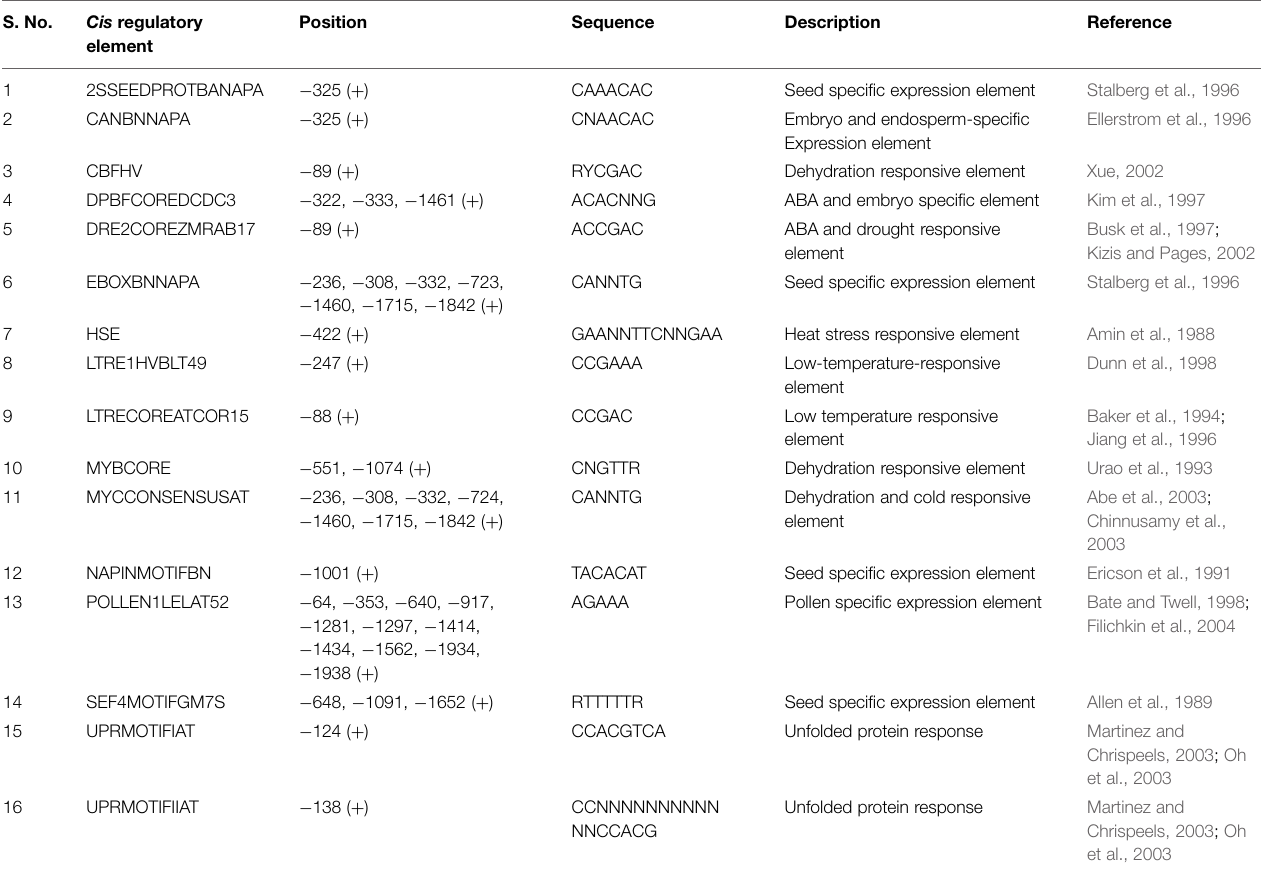
TABLE 1 | Summary of key cis regulatory elements in the 5 (cid:2) -upstream sequence of OsHSP18.2 . S.